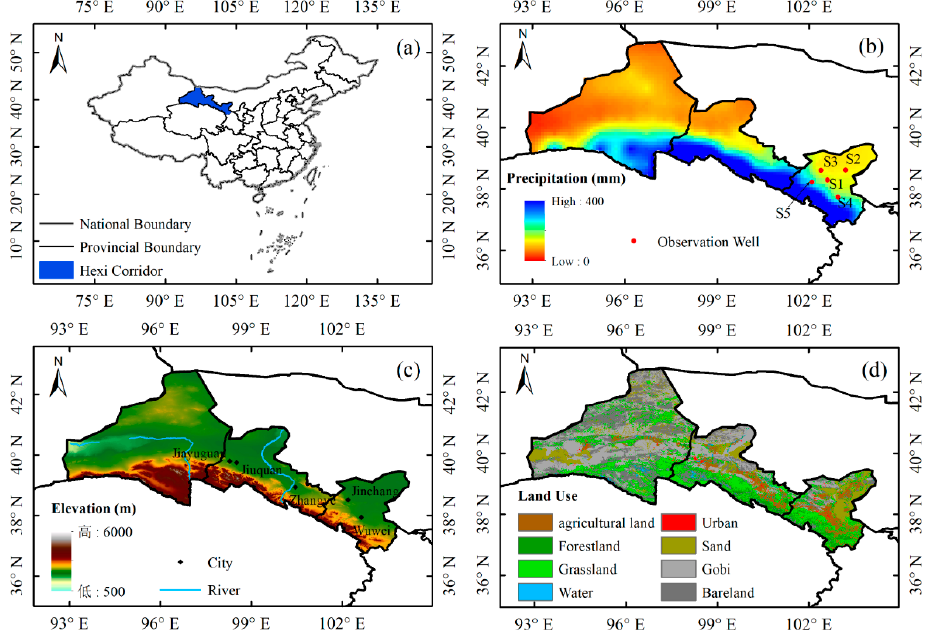
Figure 1. Information summary of the Hexi corridor: ( a ) geographical location, ( b ) annual precipitation, ( c ) digital elevation and distribution of groundwater-level monitoring points, ( d ) land use.